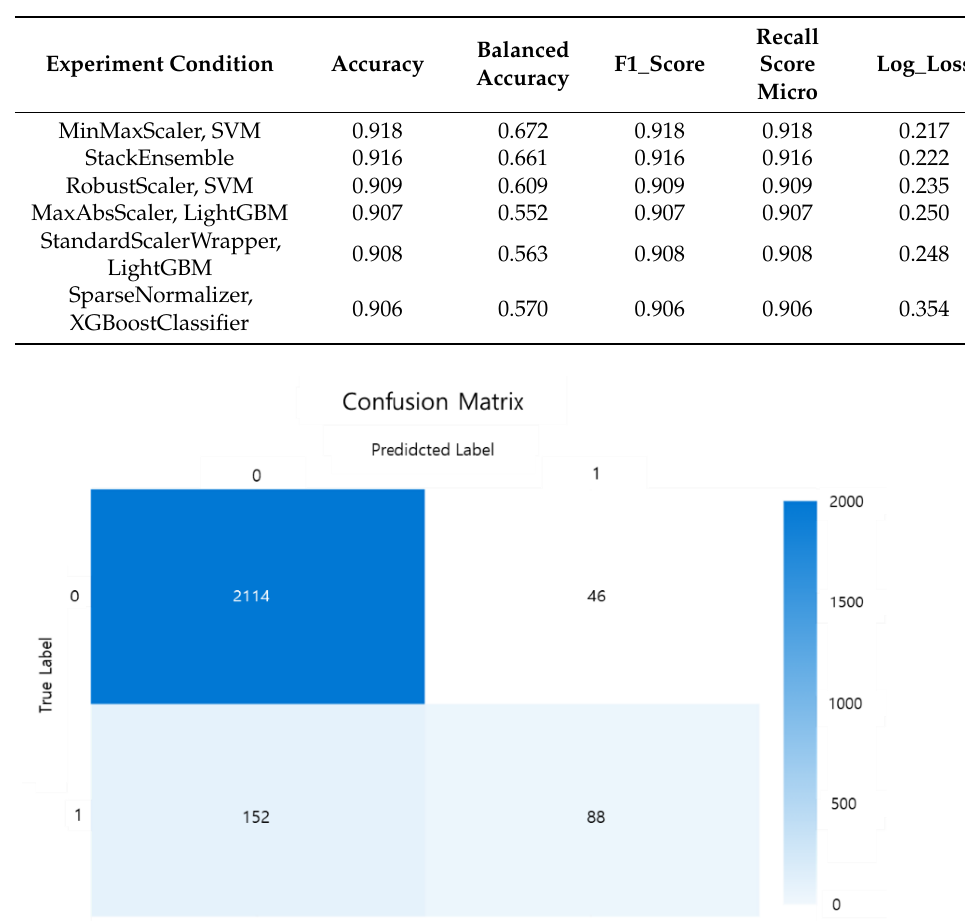
Table 1. Etching environment algorithm performance evaluation.